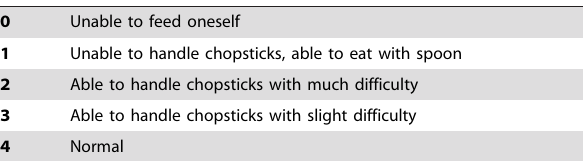
Table 1. Japanese Orthopaedic Association (JOA) scoring system for the evaluation of cervical